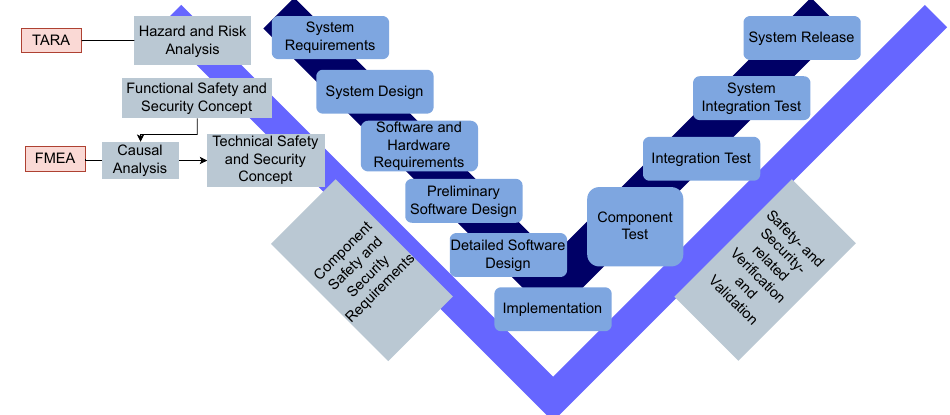
Figure 1. Safety and security analysis alongside V-model